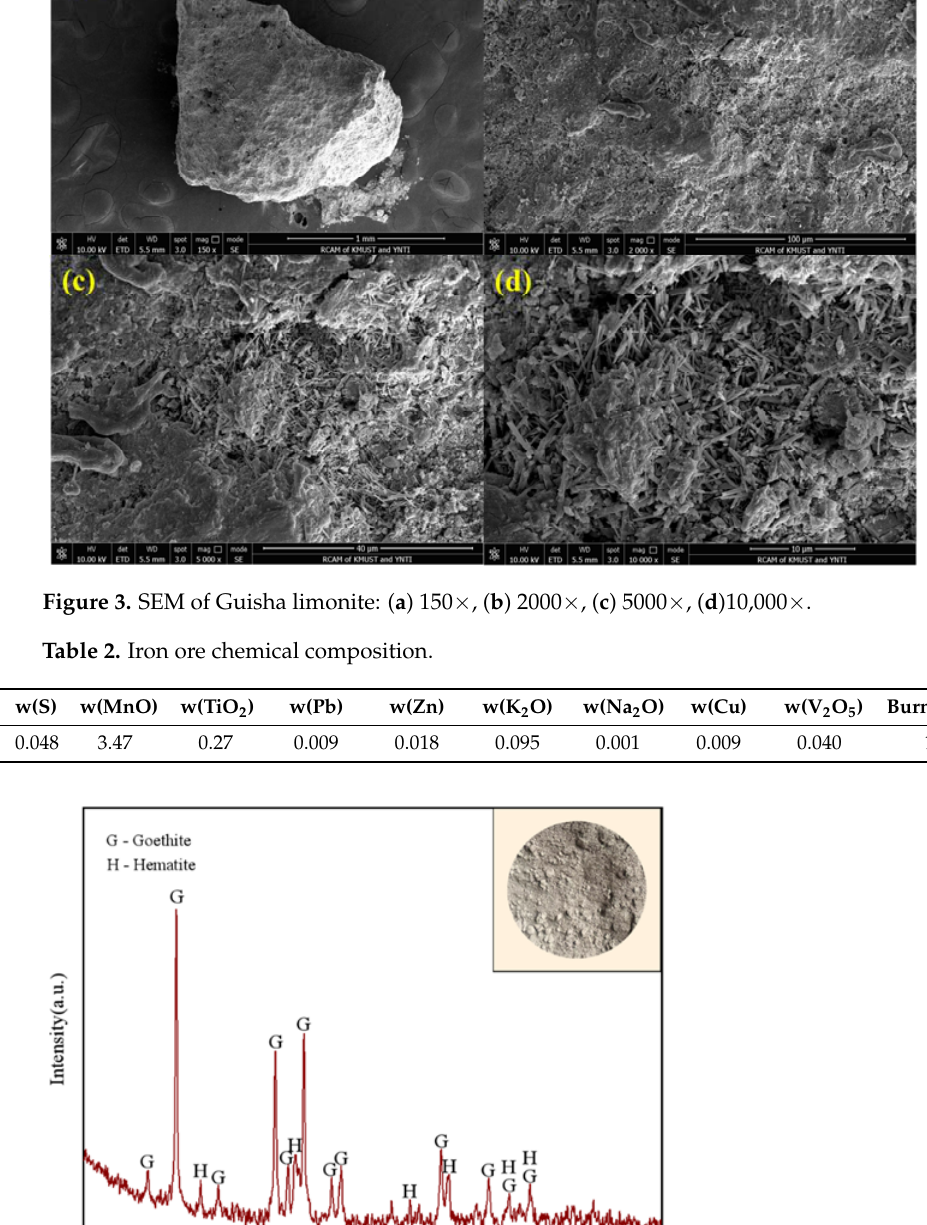
Figure 4. XRD pattern of Guisha limonite. Table 2. Iron ore chemical composition.